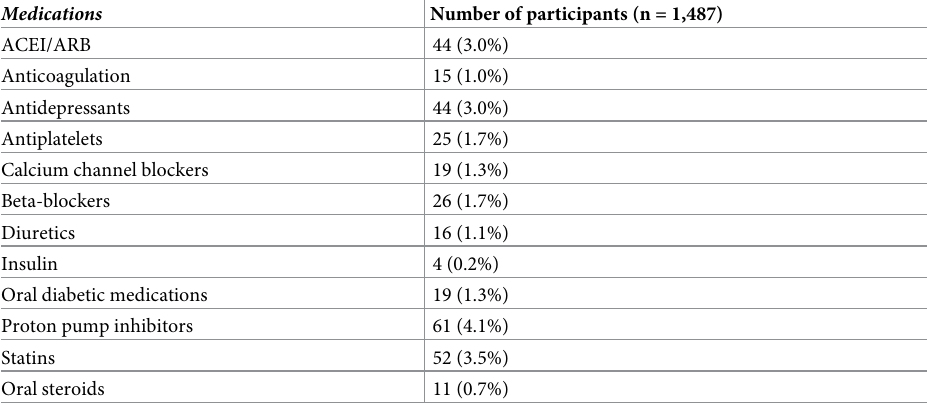
Table 2. Medications at the time of study participation.